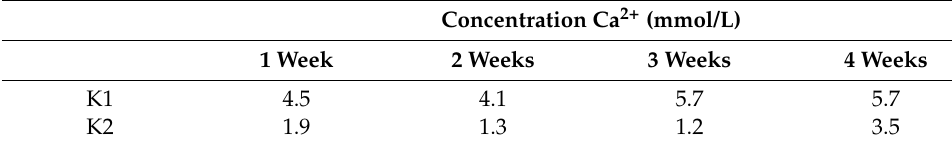
Figure 3. SEM image and histograms of composites K1 ( a ) and K2 ( b ). Table 2. Solubility of composite materials K1 and K2.